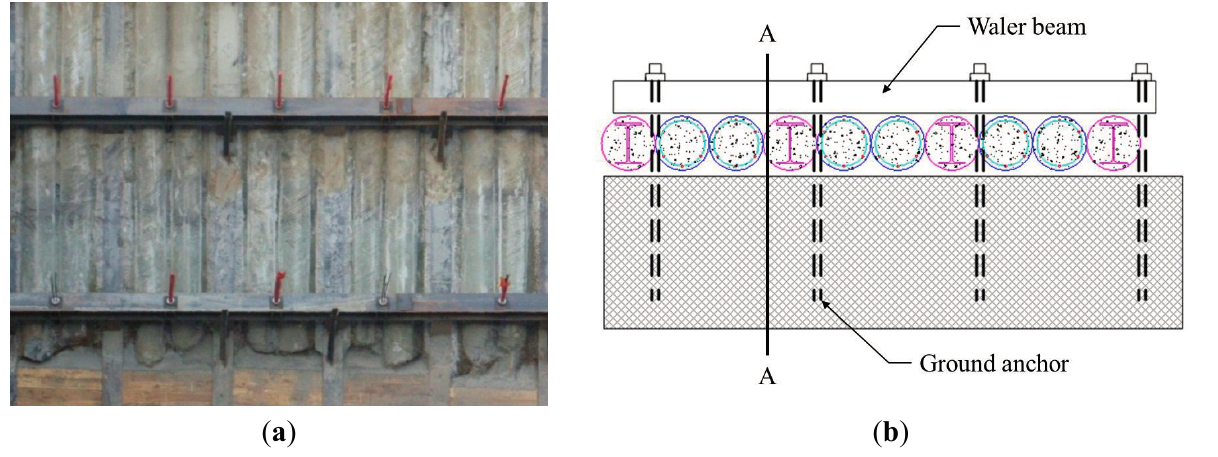
Figure 1. A multi-span waler beam supported by ground anchors in a retaining wall system: ( a ) Front view; ( b ) Side